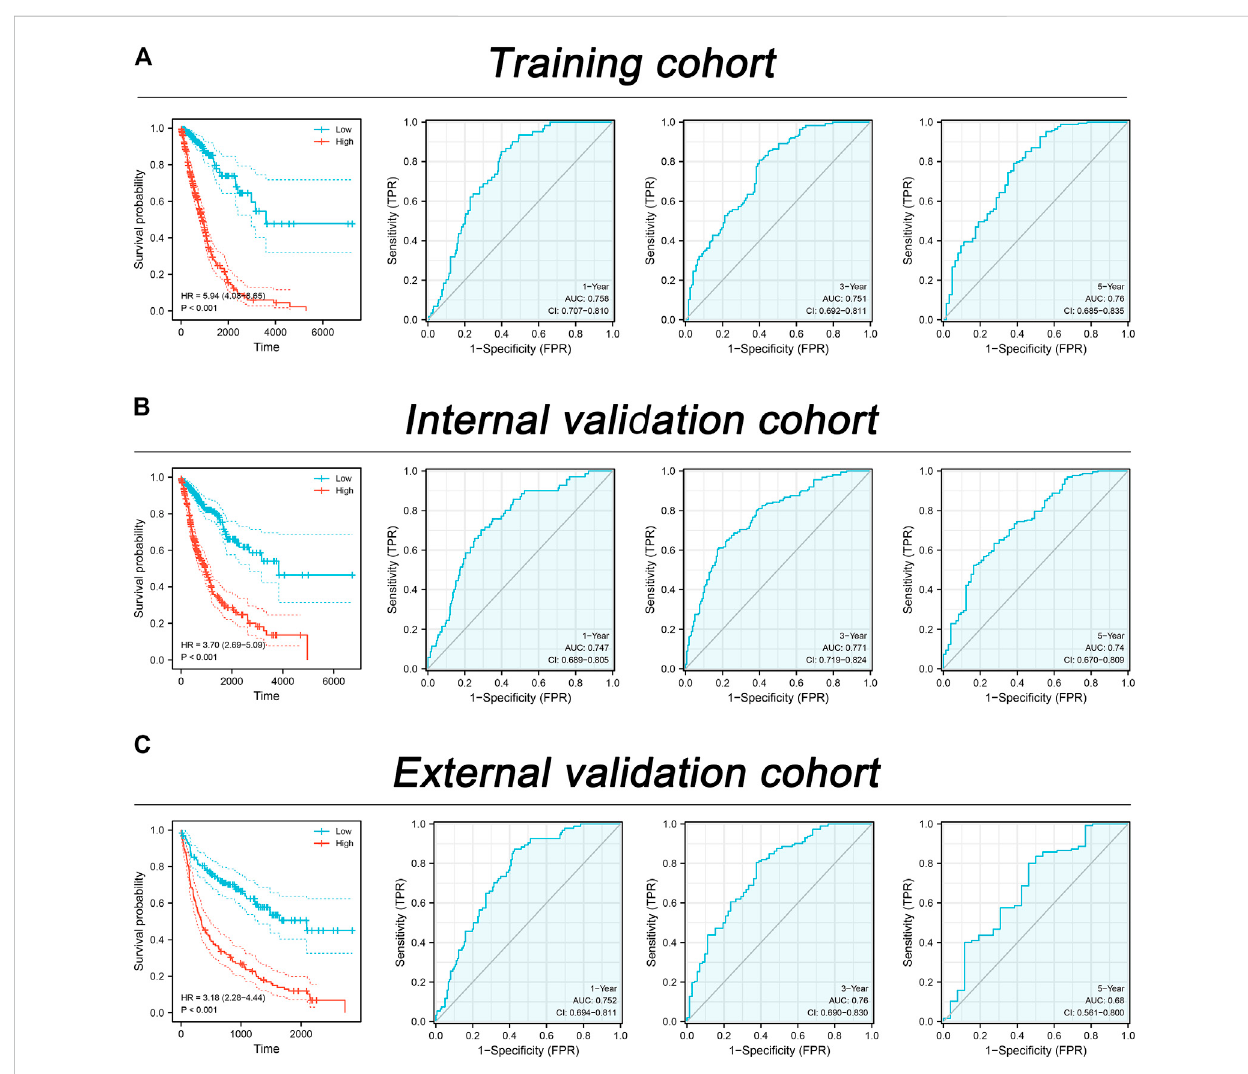
FIGURE 9 Assessment of the prognosis signature in lung cancer. Notes: (A) The performance of our signature in the training cohort; (B) The performance of our signature in the internal validation cohort; (C) The performance of our signature in the external validation cohort.